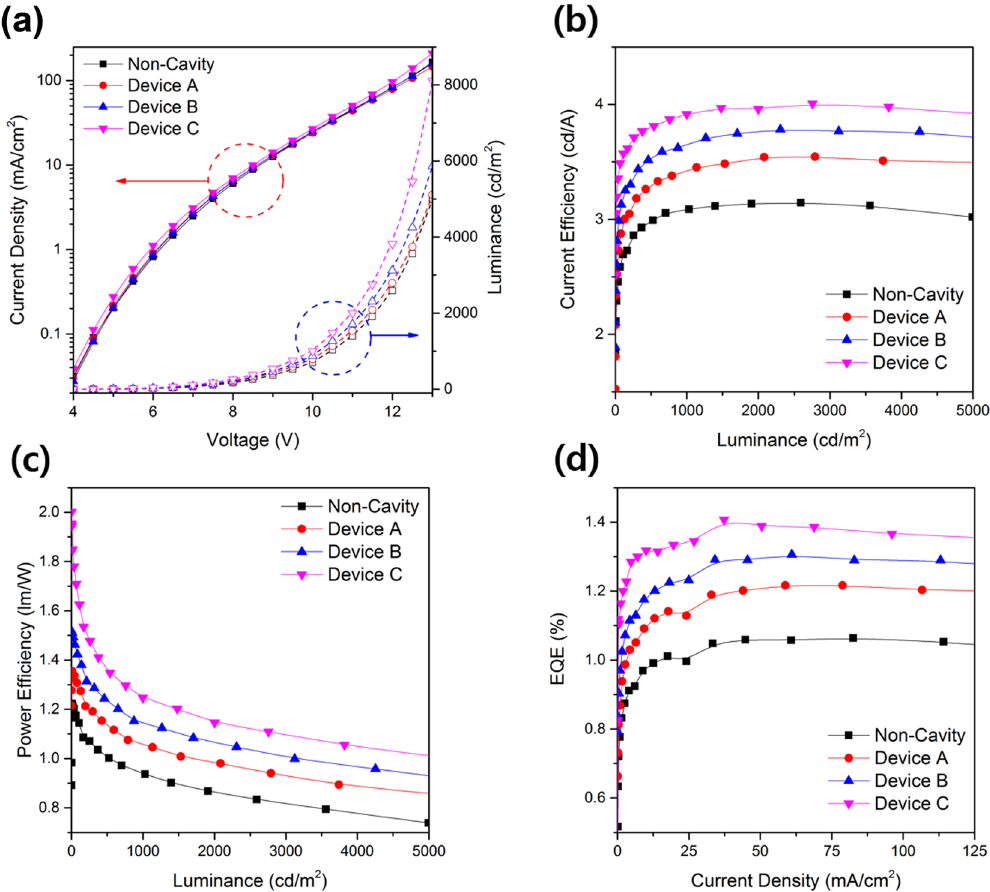
Figure 3. EL characteristics of OLEDs with diffusion layers: ( a ) current-density–voltage–luminance, ( b ) current-efficiency–luminance, ( c ) power-efficiency–luminance, and ( d ) EQE–current-density